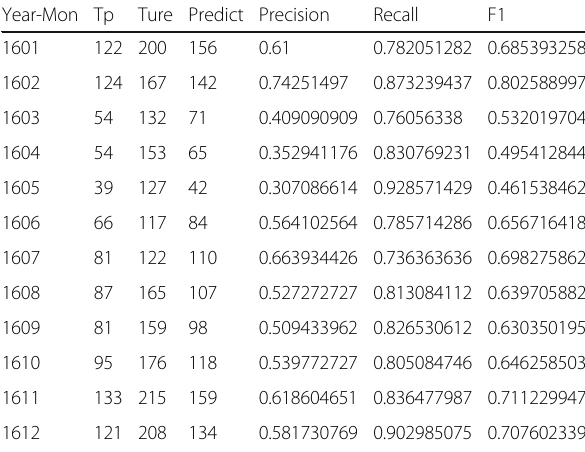
Table 1 The evaluation for prediction